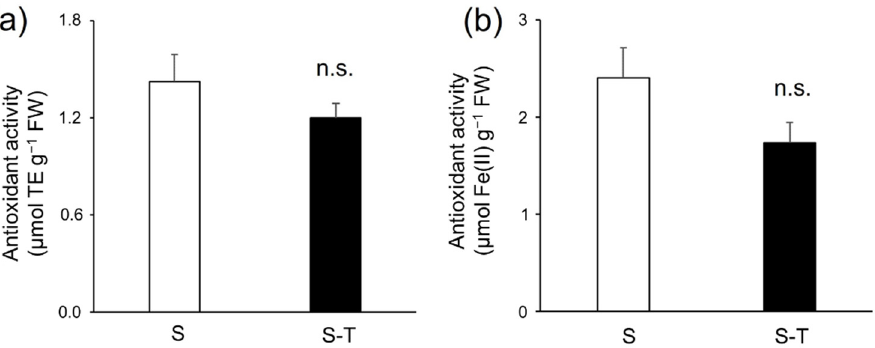
Figure 4. Antioxidant capacity measured through ( a ) ABTS and ( b ) FRAP assays of the hydroalco- holic extracts of the edible portion of Salicornia plants cultivated in monoculture (S) or in intercrop- ping with tomato plants (S-T). Data represent the mean ± SE ( n = 4). n.s. = not significant.